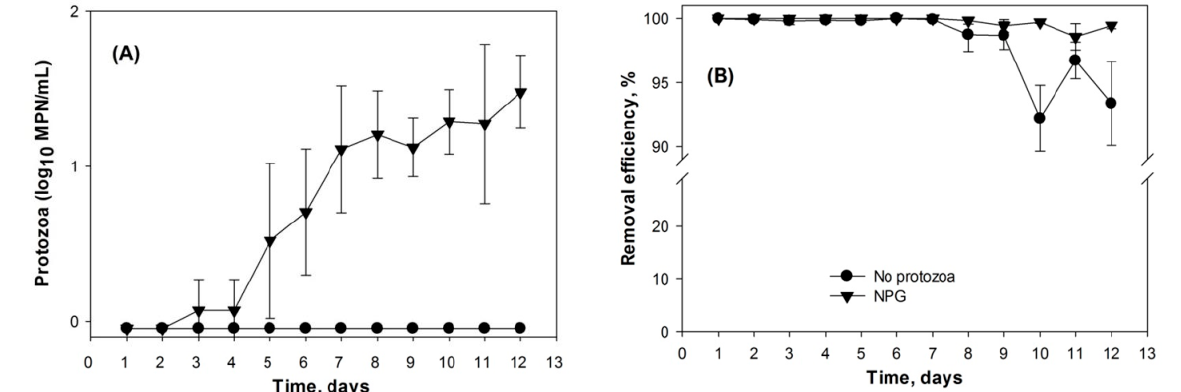
Figure 3. Protozoa response to applying E. coli to soil microcosm column. ( A ) Protozoa in effluent water, ( B ) Removal efficiencies.